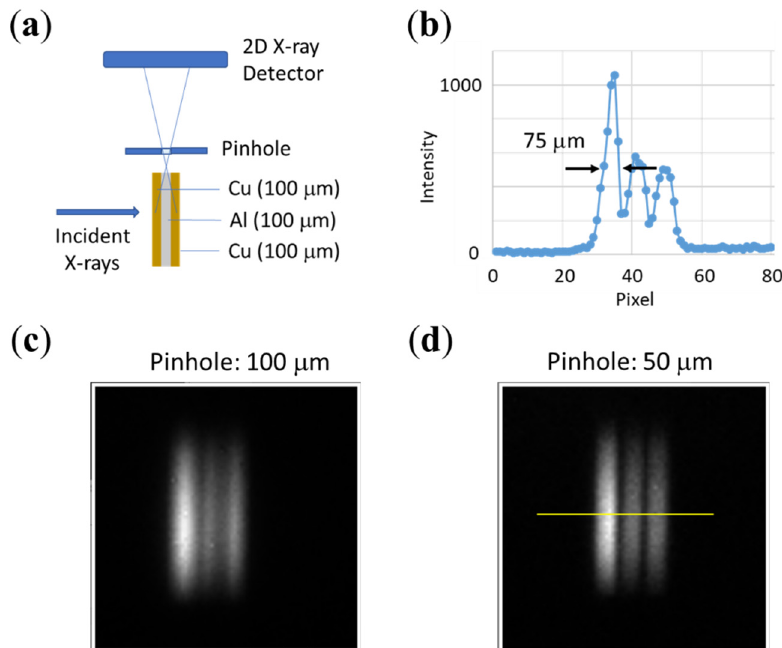
Figure 3. Spatial resolution: ( a ) sample and experimental setup; ( b ) intensity along the line in Figure 3d; ( c ) image observed with a 100 μ m pinhole; ( d ) image observed with a 50 μ m pinhole.